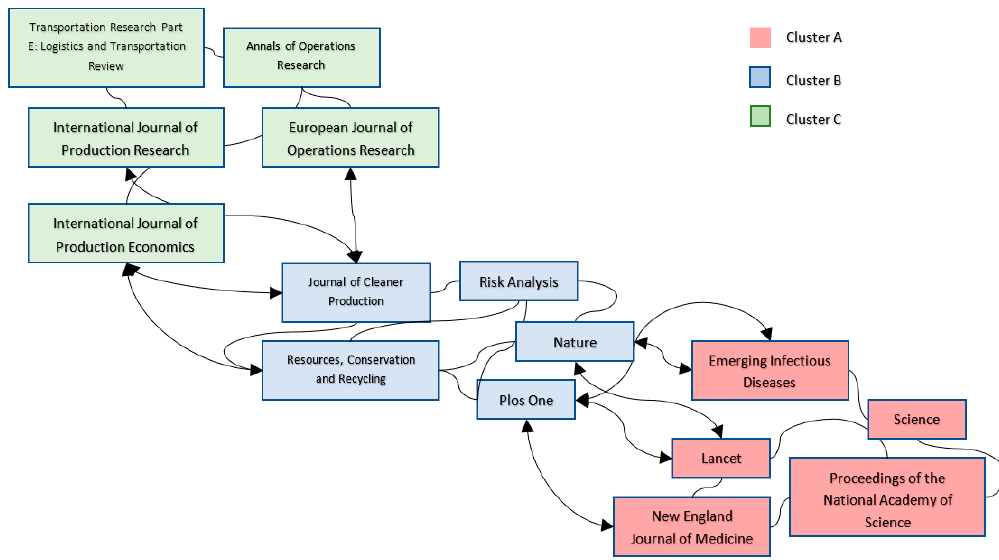
Figure 4. Hierarchical Clustering Tree Representation of Top Journals.